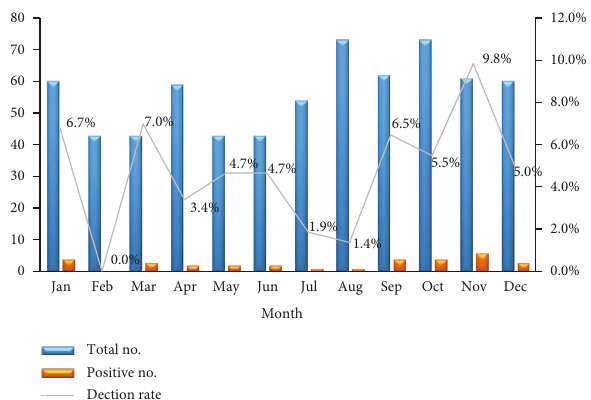
Figure 1: Monthly distribution of HAdV in hospitalized children with acute diarrhea in Shanghai between January 2006 and De- cember